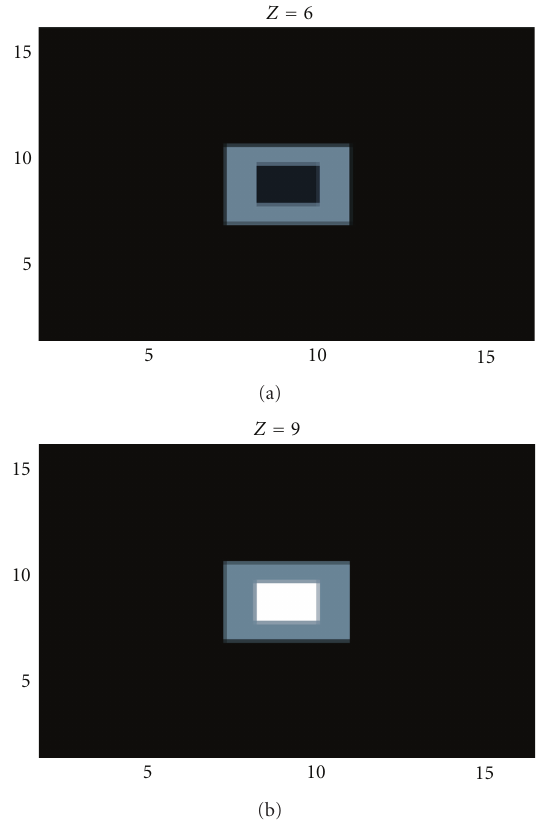
Figure 15: Two representative slices of the original object illustrat- ing two transaxial slices corresponding to the 6th and 9th planes, respectively (reprinted with permission from [20]).